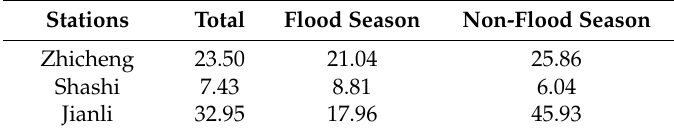
Table 6. Sectional averaged R -values of data measured before TGD dam operation.